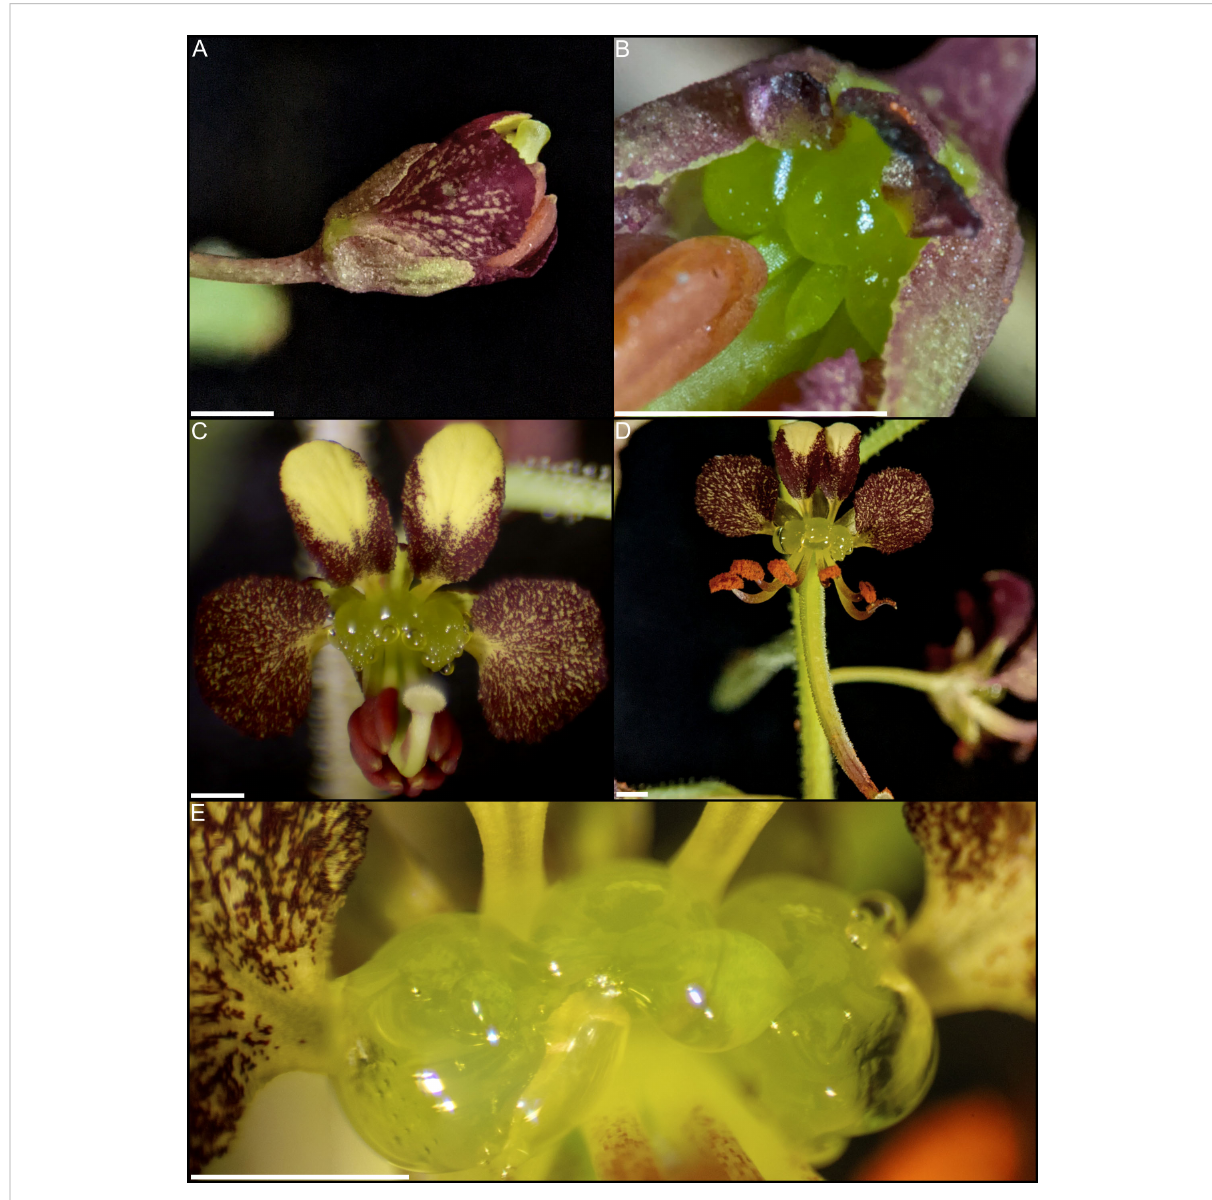
FIGURE 1 Cleome violacea fl owers at various stages of development. (A) Large undissected fl oral bud. (B) Large dissected fl oral bud showing nectary. (C) Newly anthetic fl ower. (D) Post-anthetic fl ower with developing fruit. (E) Magni fi ed view of anthetic nectary. Scale bars = 1